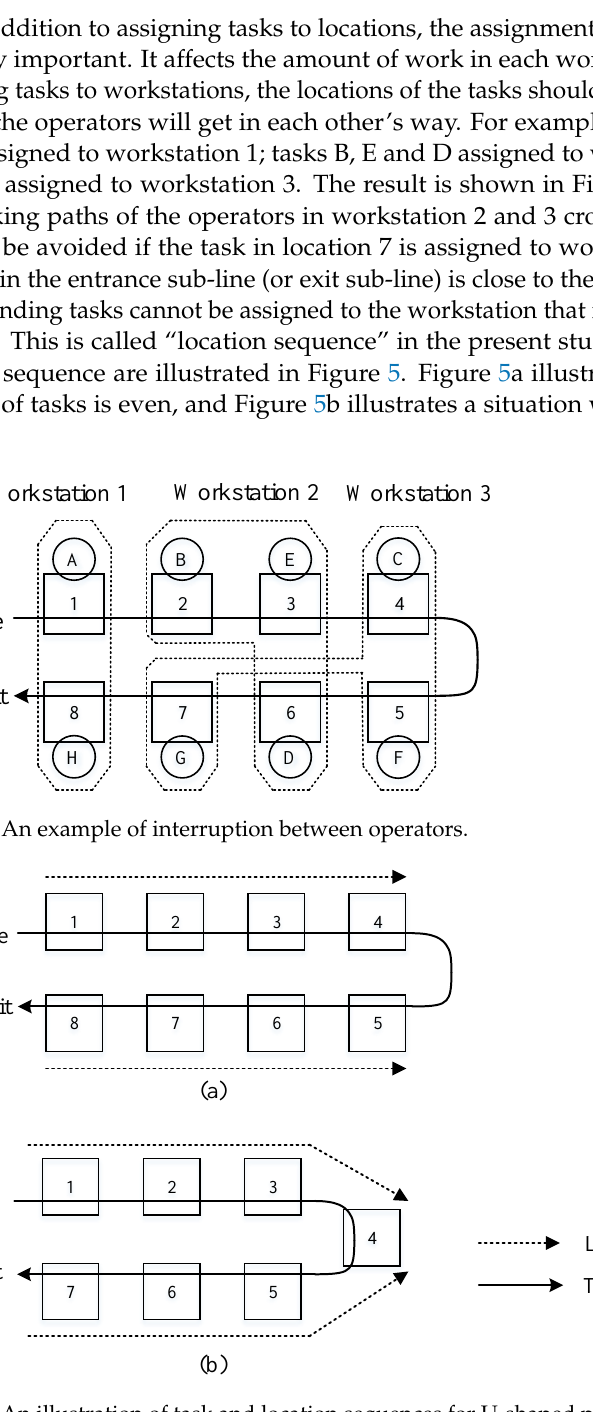
Figure 5. An illustration of task and location sequences for U-shaped production line. ( a ): number of tasks is even ; ( b ): number of tasks is odd.